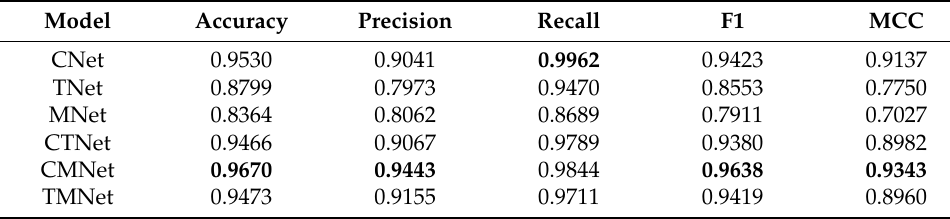
Table 2. Table of comparison of indicators for the hybrid models in this study.